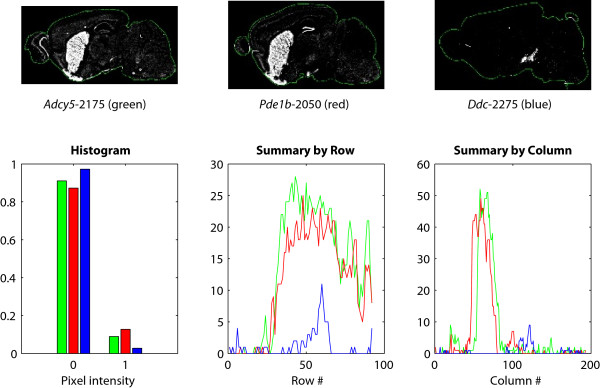
The mask images of slide 2175 of Adcy5, slide 2050 of Pde1b, and slide 2275 of Ddc. Adcy5 and Pde1b show similar expression profiles, while Ddc is expressed differently. The pixel intensity histogram, row vector, and column vector (H, R, and C, respectively) for the three genes are shown. Green represents Adcy5, red is for Pde1b, and blue is for Ddc.